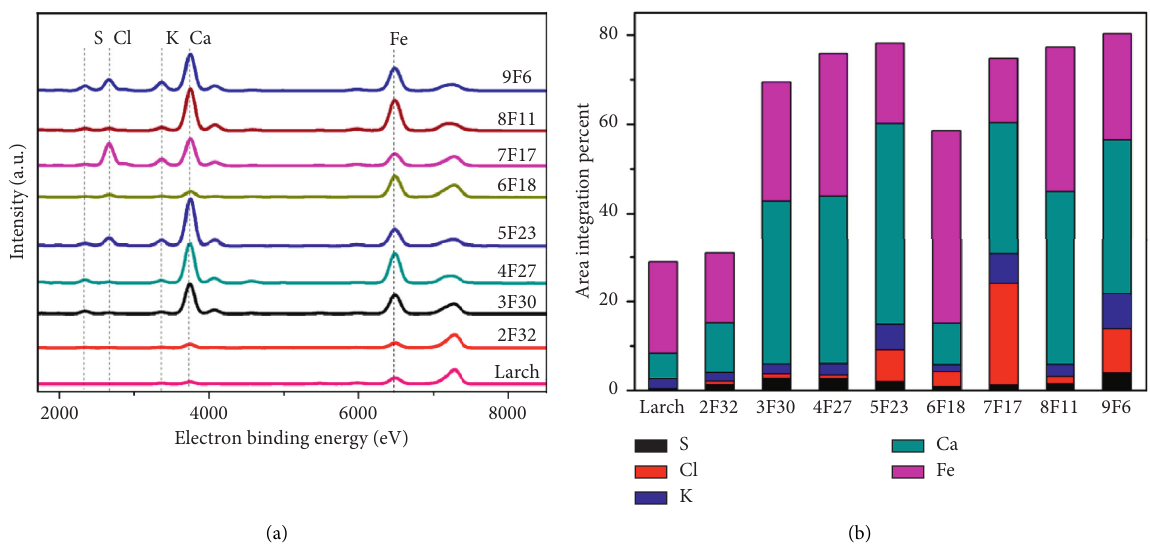
Figure 4: (a) XRF spectra of the aged and sound wood samples, where the well-resolved peaks of sulphur, chlorine, potassium, calcium, and iron ion can be detected. (b) Area integration percent of the elements in the aged and sound wood samples. The aged samples (9F6, 8F11, 7F17, 5F23, and 4F27) contain more inorganic element content than the sound sample, particularly the contents of calcium, sulphur, chlorine, and iron ions.